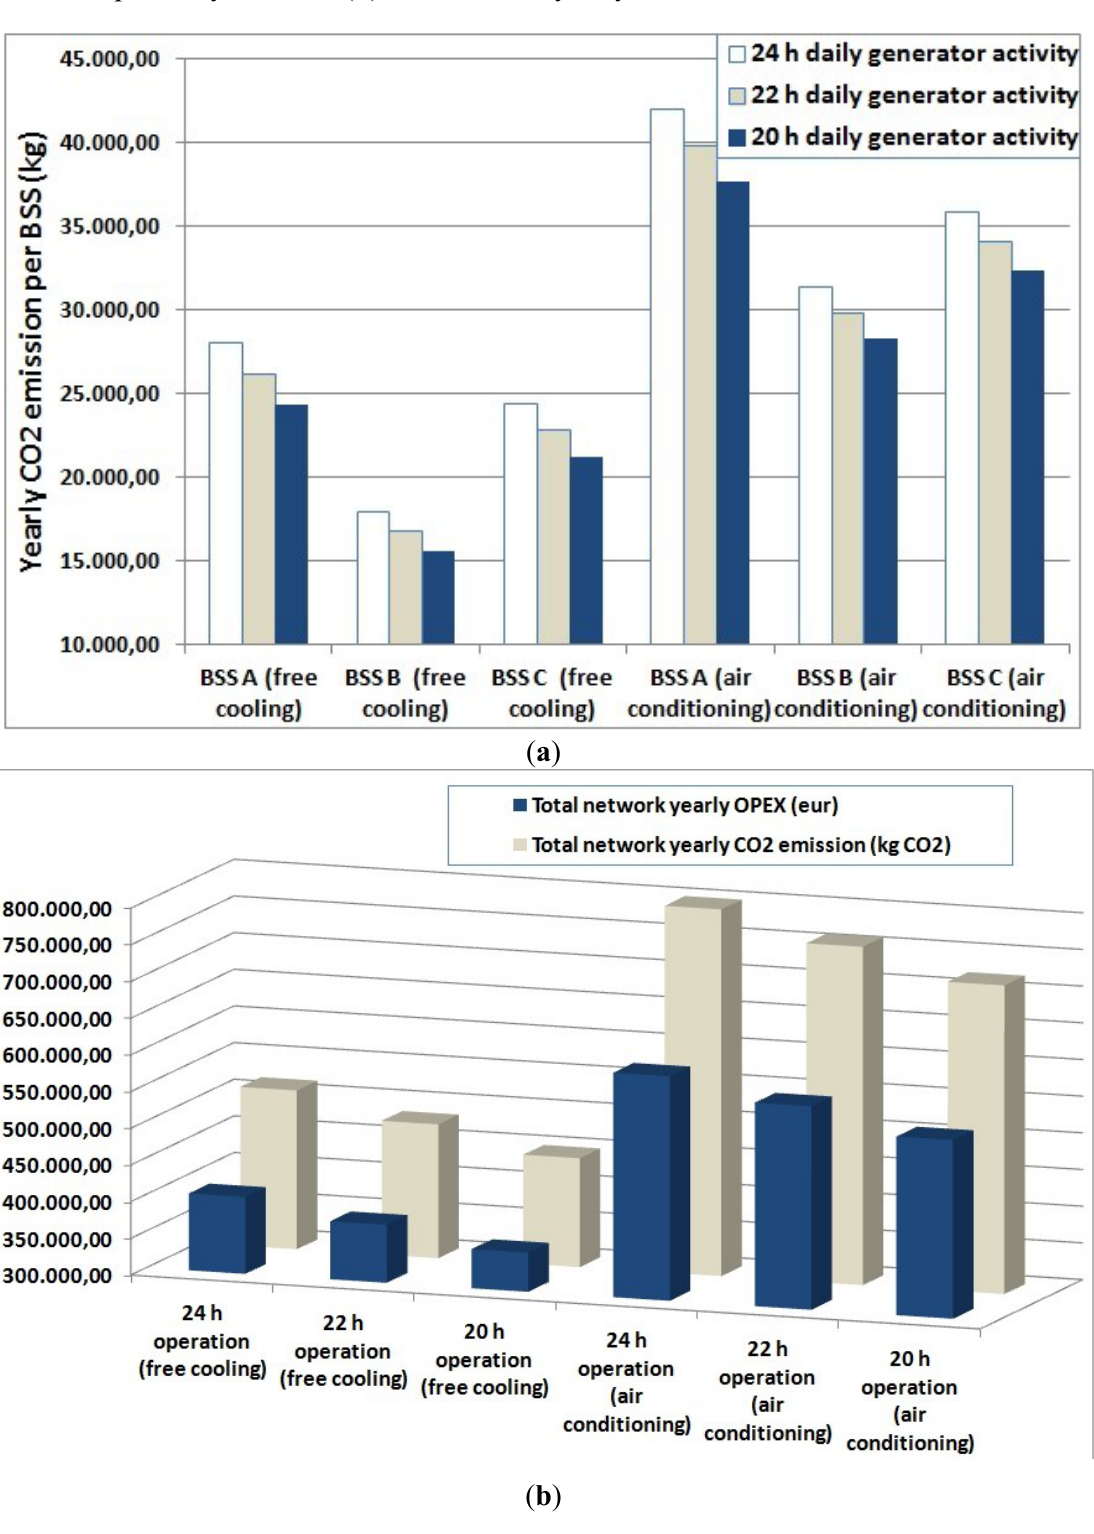
Figure 18. For different operating modes of power generators: ( a ) yearly CO 2 emissions reduction per analyzed BSS; ( b ) total network yearly CO 2 emission and OPEX